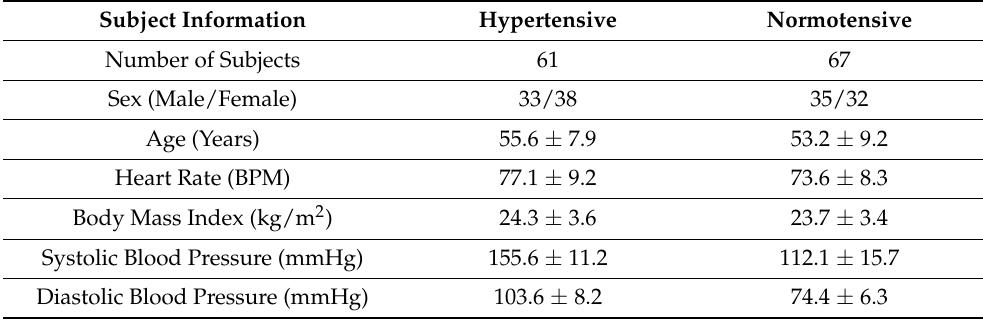
Table 1. Statistical information about the used dataset